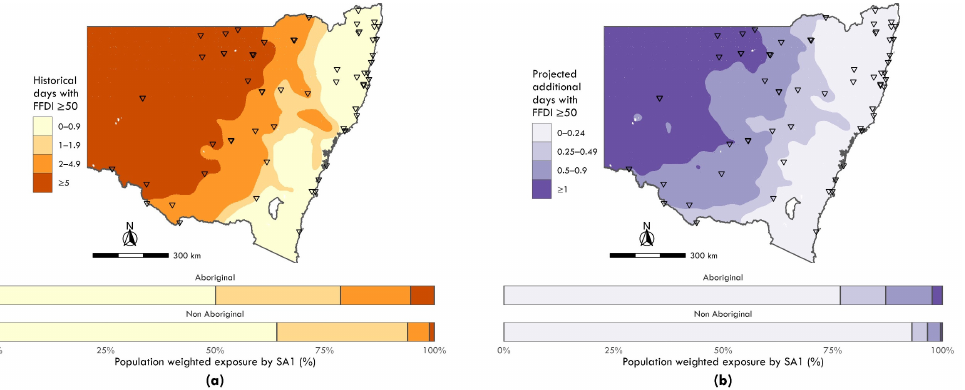
Figure 3. Maps of annual days with Macarthur Forest Fire Danger Index exceeding 50 (i.e., “severe”